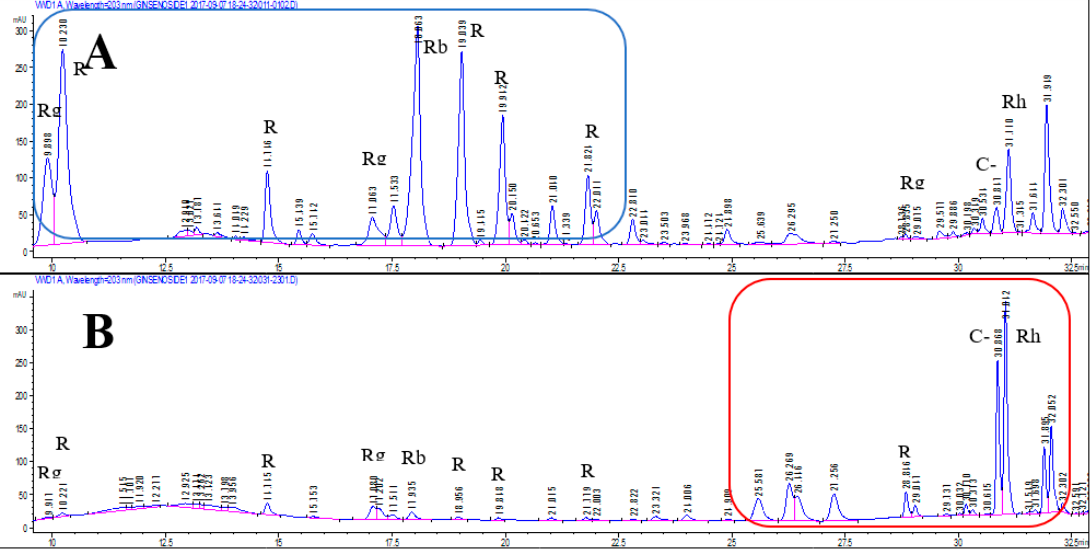
Figure 1. HPLC chromatograms of ( A ) non-puffed CWPG and ( B ) puffed CWPG. Representative histogram of puffed CWPG at 10% moisture content and 784 kPa puffing pressure is presented to visualize changes of peaks.